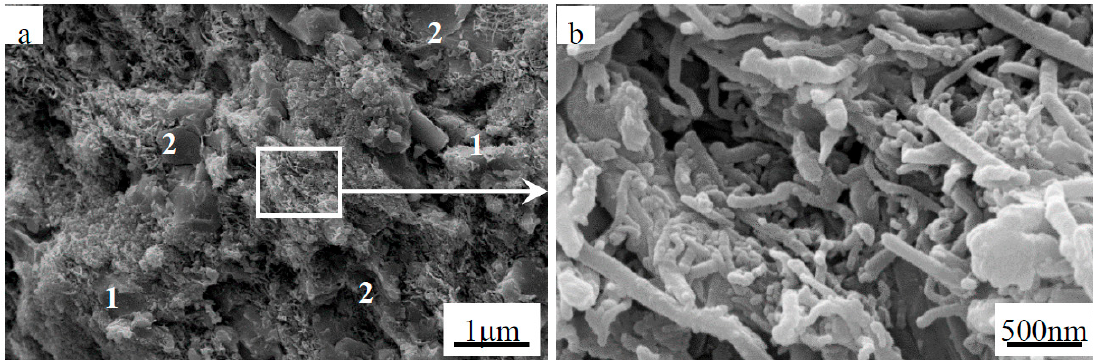
Figure 5. Secondary electron SEM images of ( a ) fracture surface of ZrB 2(nano) -7 wt % CNTs composites (“1” represents intergranular fracture, “2” represents transgranular fracture); and ( b ) magnified region.